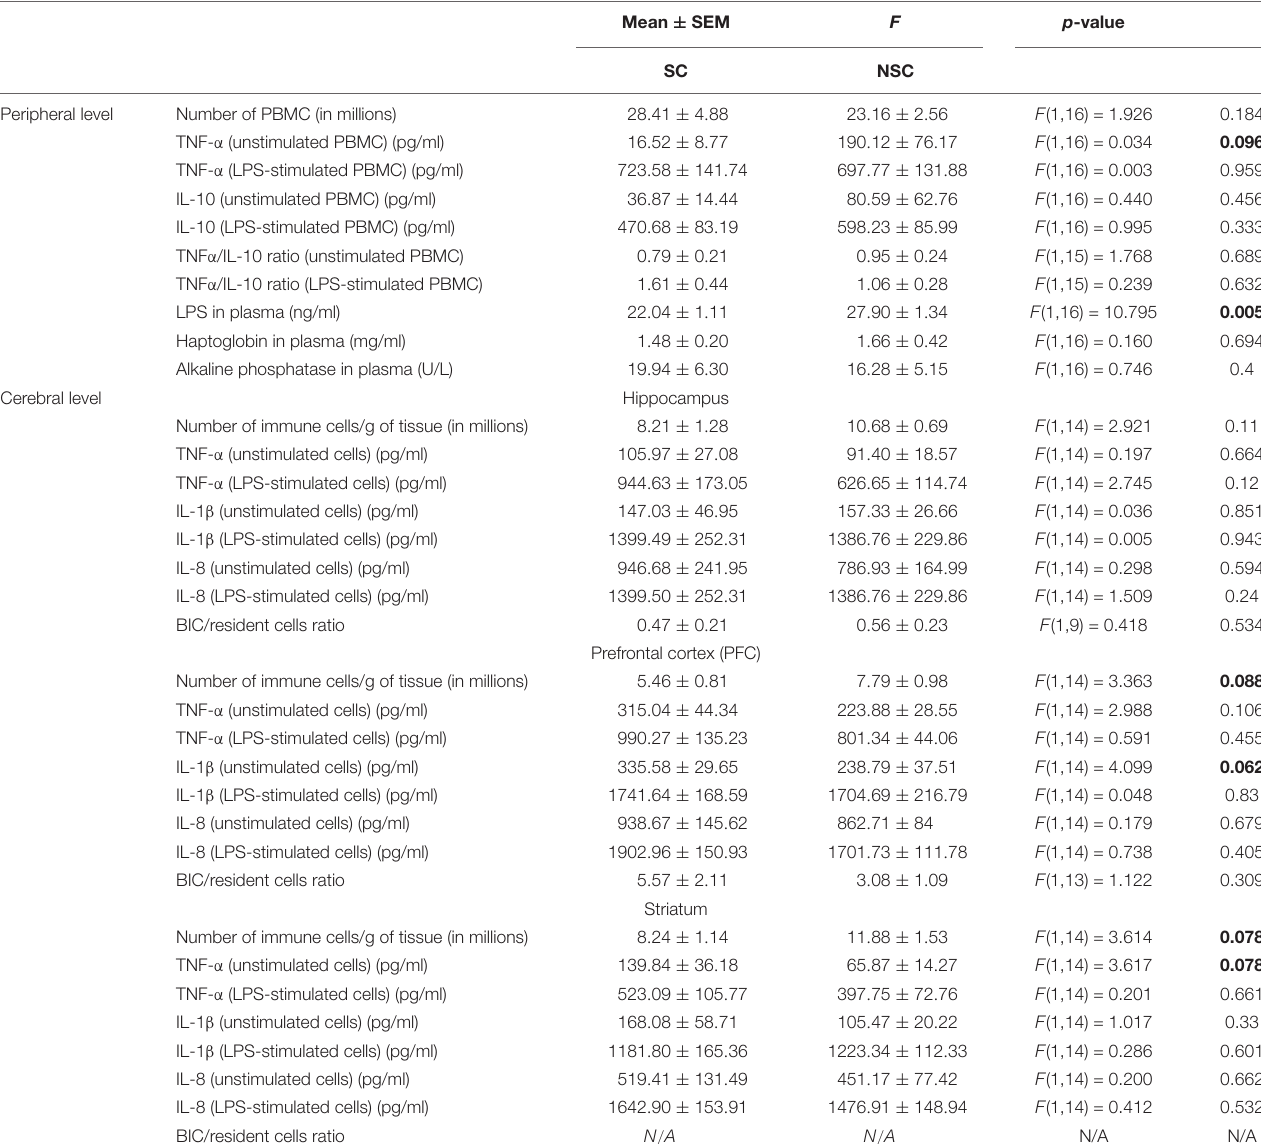
TABLE 1 | Peripheral and brain immunological